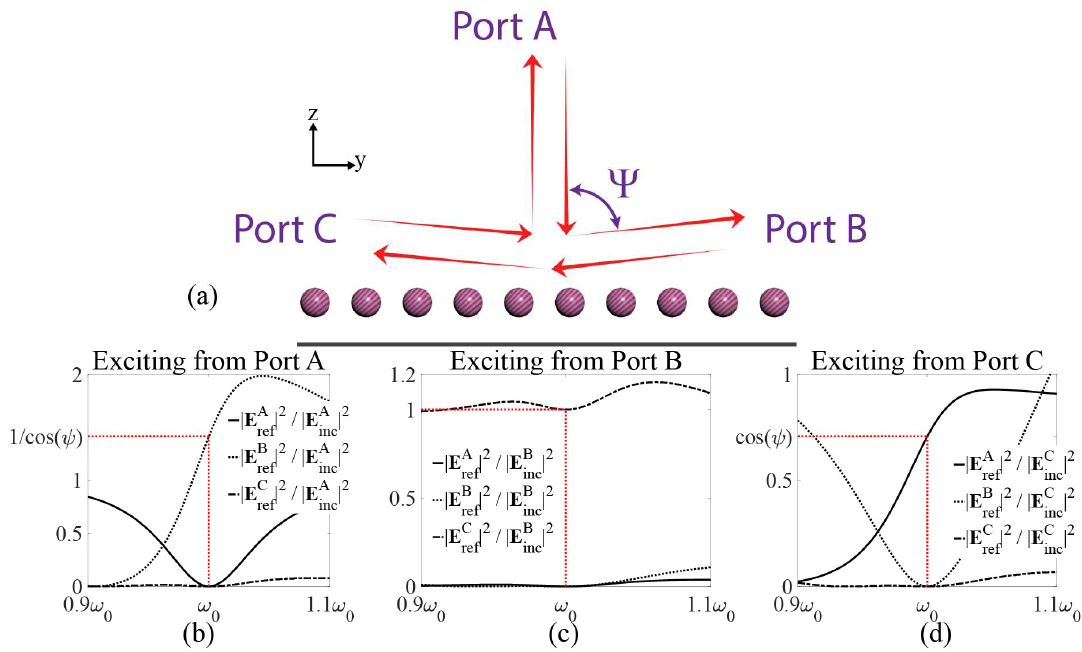
Figure 1. ( a ) Schematic of a nonreciprocal metagrating (side view). Amplitudes of the reflected wave into di ff erent Floquet channels when exciting from ( b ) Port A, ( c ) Port B, and ( d ) Port C. For this specific design, we assume ω ee = ω em = ω mm = ω 0 and δ ee = 2 δ em = 4 δ mm = 0.4 ω 0